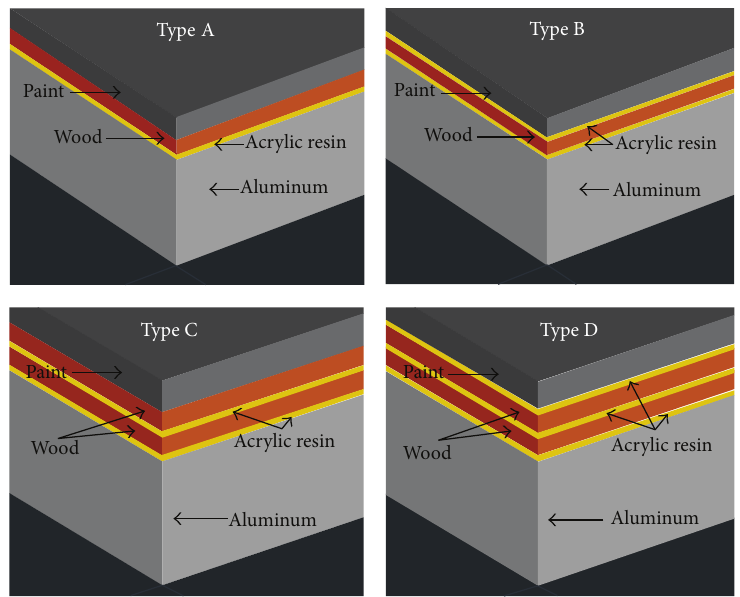
Figure 2: Scheme of the investigated coating systems.